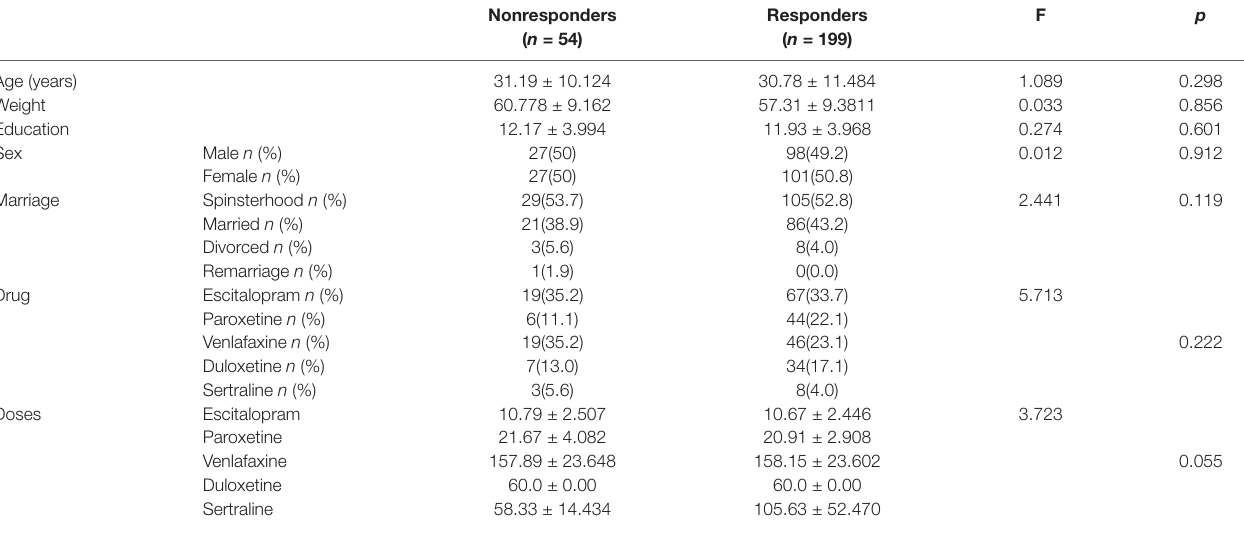
TABLE 2 | Clinical features, dosage, and drug among the responders and the